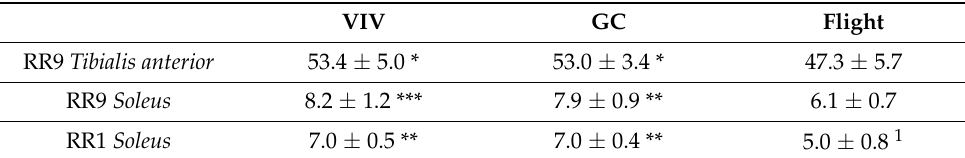
Table 1. Absolute muscle mass (mg) from NASA Rodent Research 1 (RR1) and Rodent Research 9 (RR9) missions.